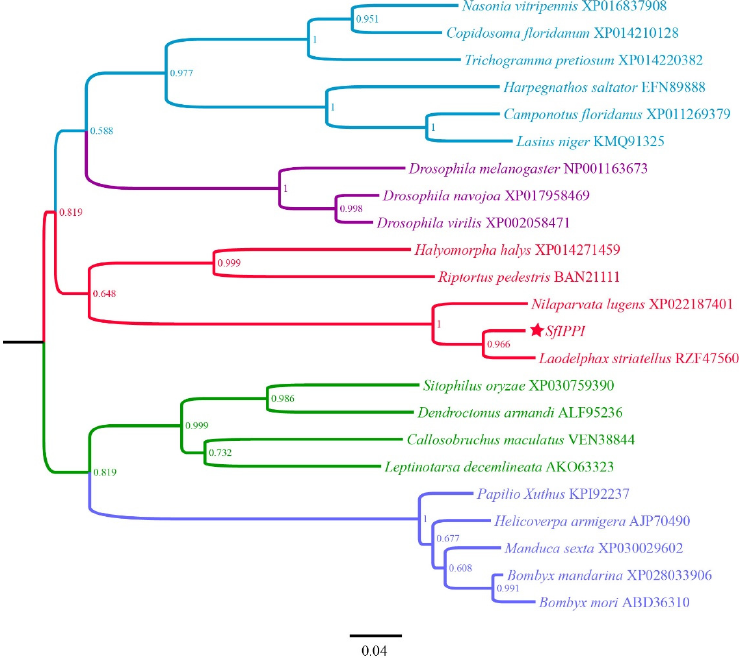
Figure 2. Phylogenetic analysis of SfIPPI homologs from insect species based on amino acid sequences. Sequences were downloaded from the GenBank protein database. The red star indicates the IPPI gene of S. furcifera .